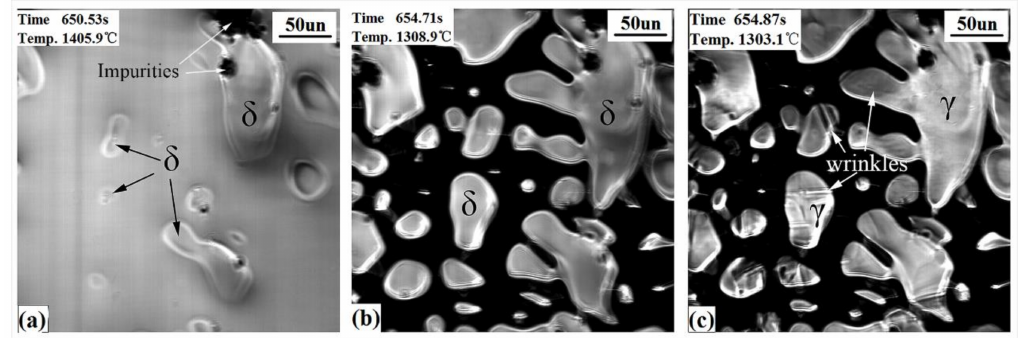
Figure 5. CSLM results of the ultra-low carbon steel (S2) at cooling rate of 20 ◦ C/s. ( a ) δ growth; ( b , c ) before and after δ – γ